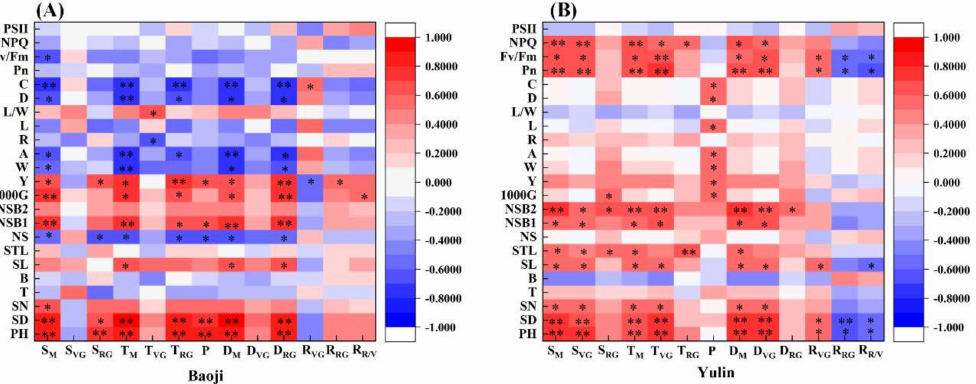
Figure 5. The correlations between plant and grain parameters and meteorological factors and growth periods in Baoji ( A ) and Yulin ( B ). R VG represents the vegetative growth period; R RG represents the reproductive growth period; R V/R represents the ratio of vegetative growth period to reproductive growth period. W width, A grain area, R grain roundness, L grain length, L/W grain length/width, D grain diameter, C grain circumference, respectively. These apply to other figures and tables. * and ** represent significant correlations at the levels of p < 0.05 and p <